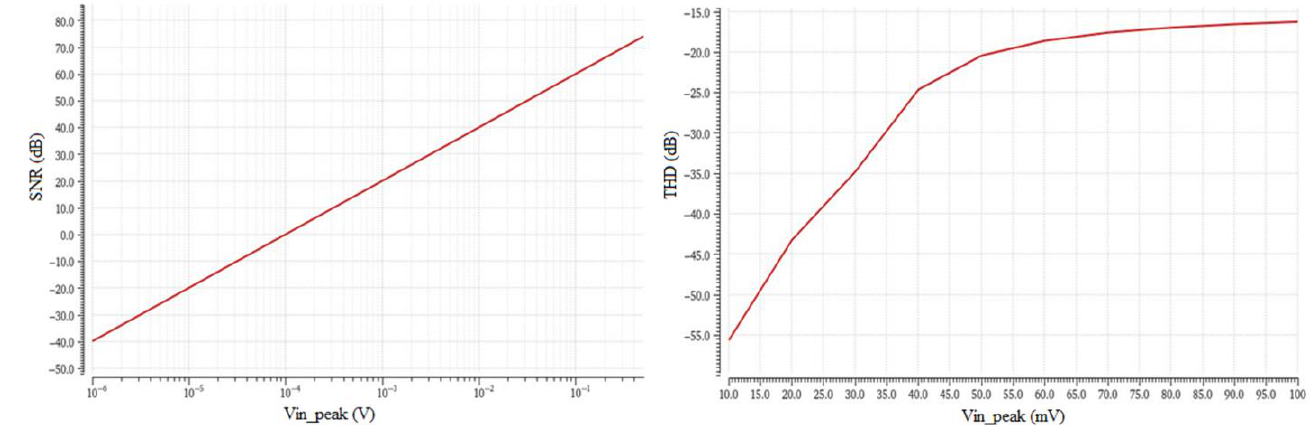
Figure 16. Signal-to-Noise Ratio (SNR) vs. V in_peak and Total Harmonic Distortion (THD) vs. Vin_peak.